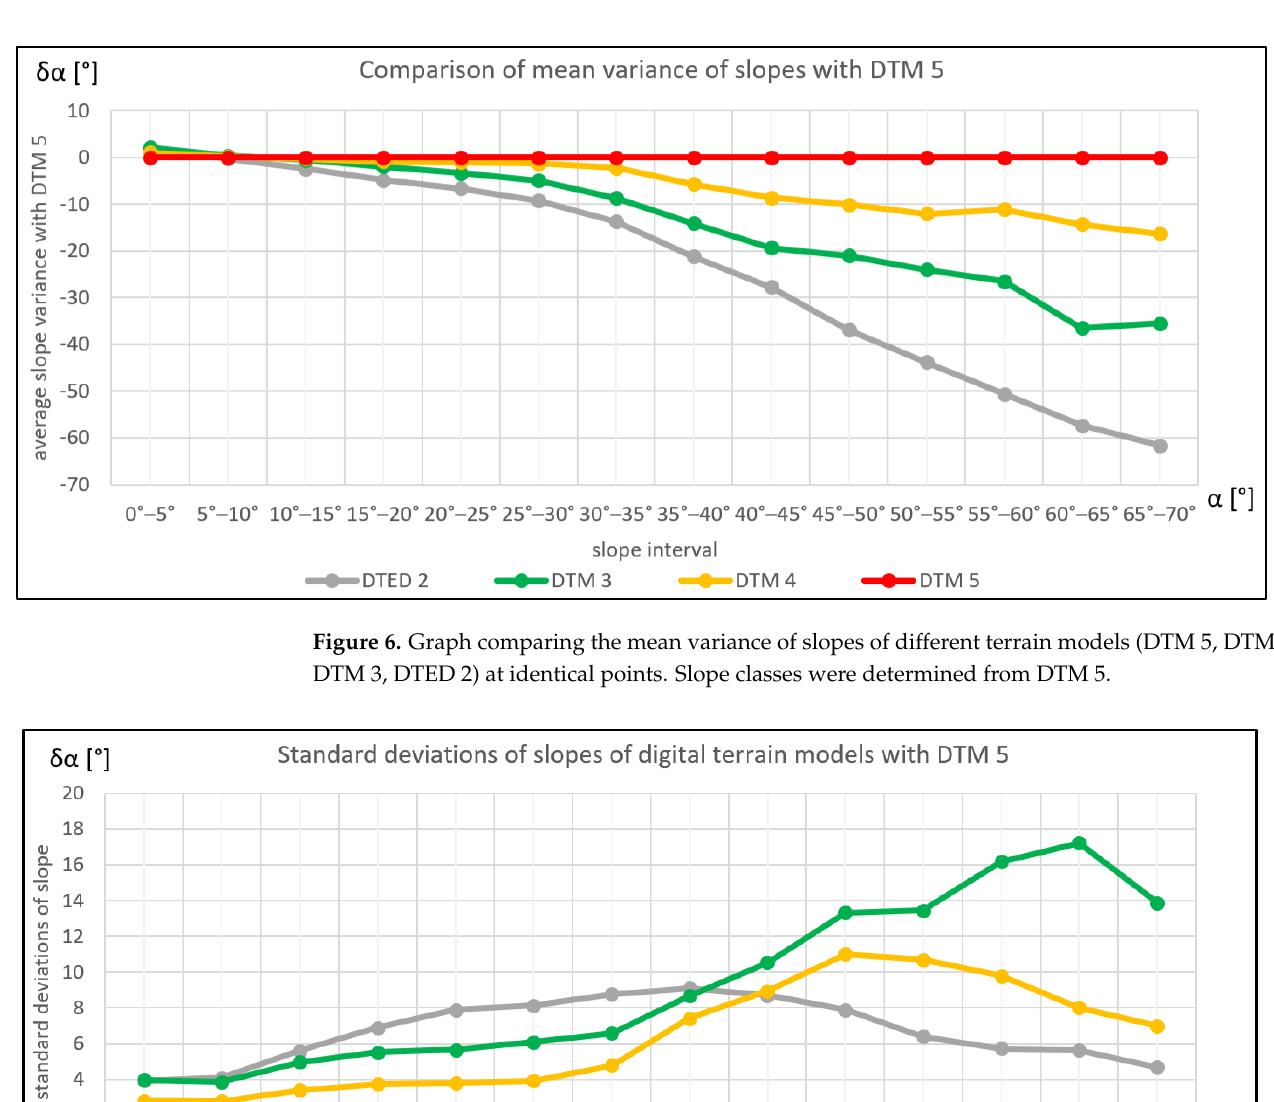
DTED 2) at identical points. Slope classes were determined from DTM 5.